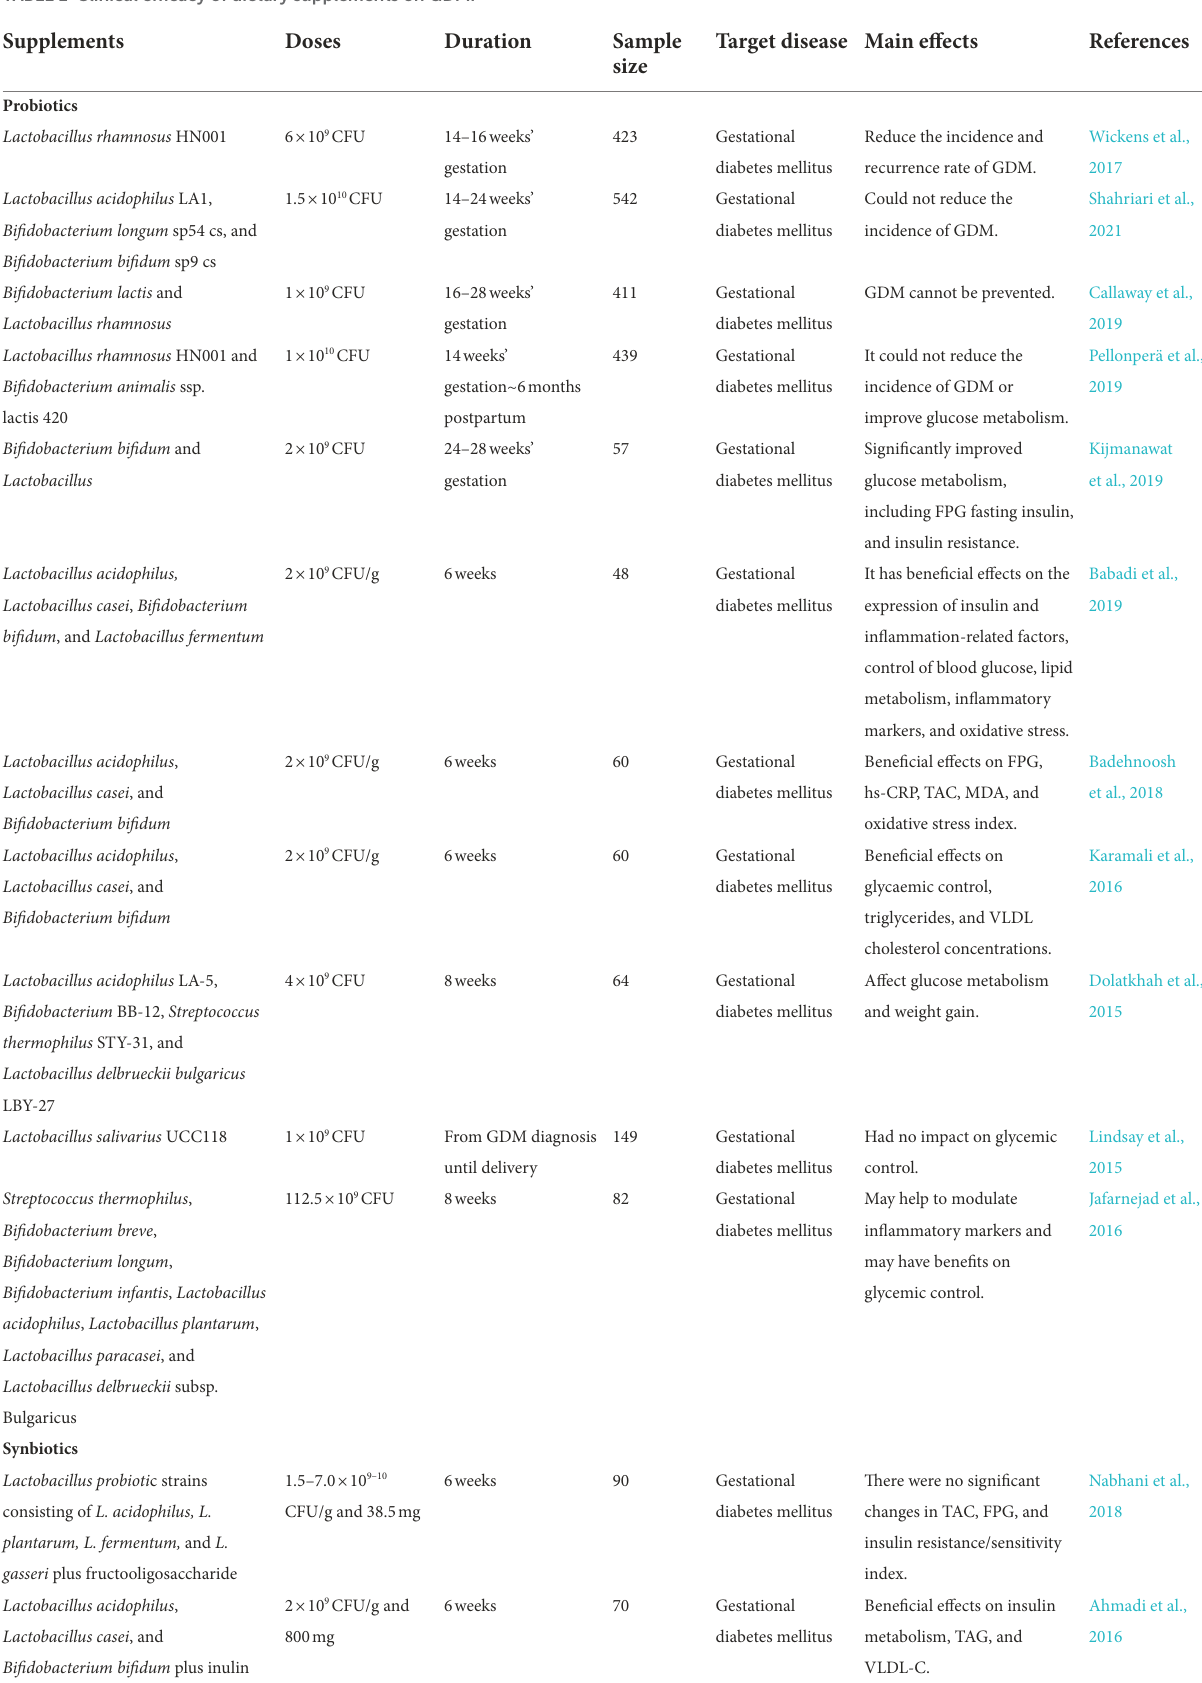
TABLE 1 Clinical efficacy of dietary supplements on